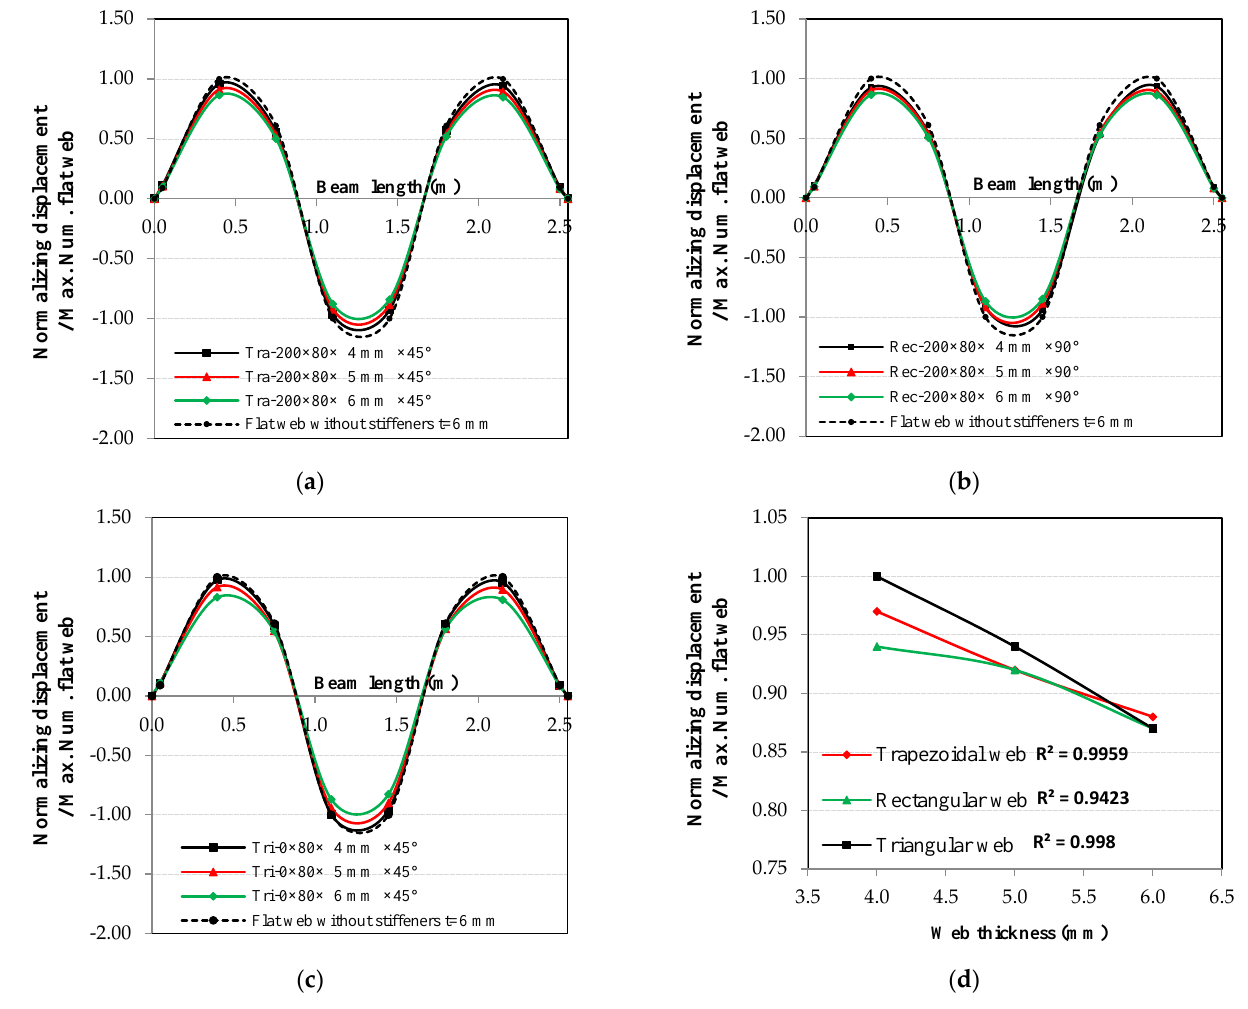
Figure 11. Thickness effect on the relationship between normalized displacement and beam length for the 3rd mode shape: ( a ) trapezoidal web, ( b ) rectangular web, ( c ) triangular web, and ( d ) thickness effect at the 3rd mode shape.